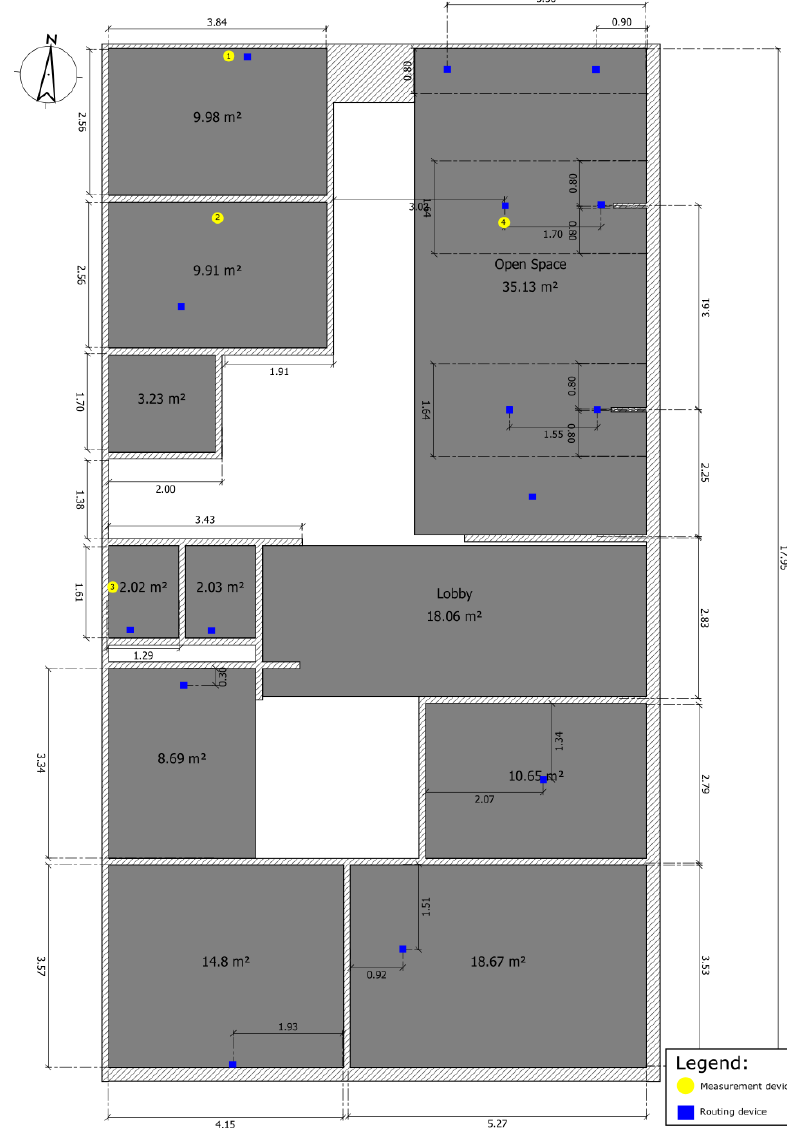
Figure 8. Office environment where the measurements were